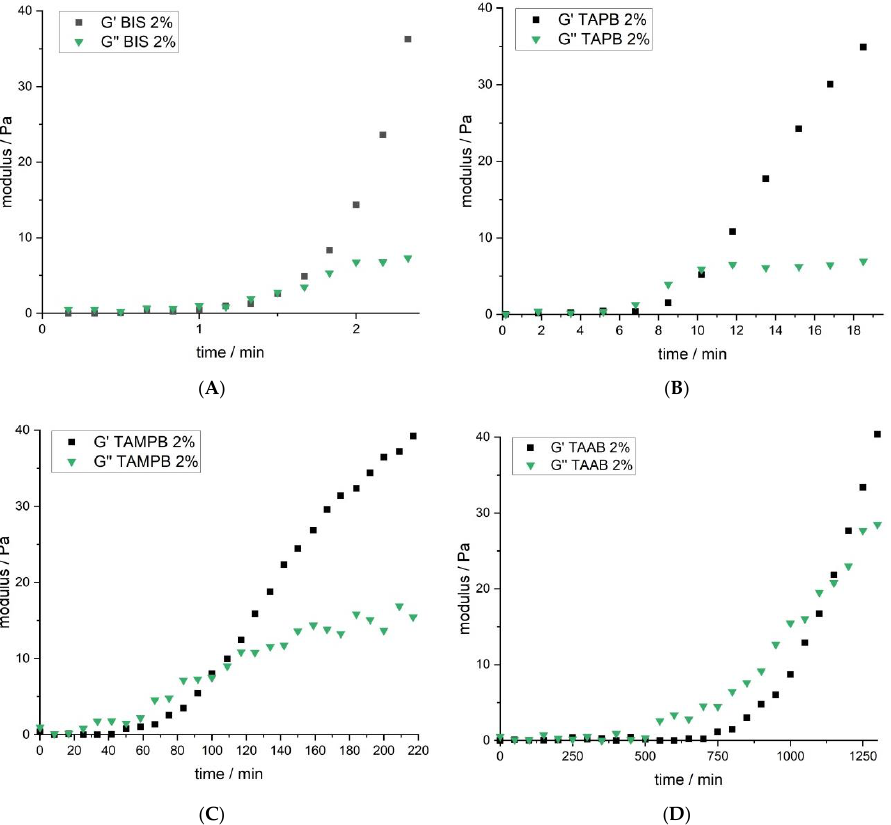
Figure 5. Storage G ’ and loss modulus G ’’ as a function of time for mixtures containing DADMAC and 2 mol% of the four cross-linkers ( A ) BIS, ( B ) TAPB, ( C ) TAMPB and ( D ) TAAB shown in Figure 1 at 20 °C, recorded at an amplitude of 1 Hz and 1% deformation. Note the different scale of the x-axes. As can be seen from the copolymerisation diagram, gels made with BIS incorporate